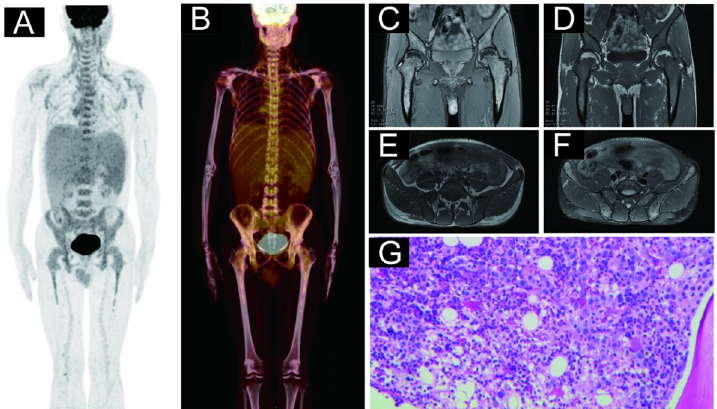
Fig 6. Representative case of a 45-year-old male diagnosed with diffuse large B-cell lymphoma. (A) and (B): Coronal positron emission tomography (PET) and PET-computed tomography images, respectively, revealing increased diffuse 18 F-fluorodeoxyglucose uptake (higher than that in the liver) in bone marrow throughout the patient’s body. (C)–(F): Pelvic magnetic resonance imaging revealing low signal intensity in the ilium, bilateral upper femur bones, and sacrum on the T1-weighted image, and high signal intensity in the same regions on the fat- suppressed T2-weighted image. (G): Hematoxylin and eosin staining confirmed bone marrow involvement in this patient. The patient’s blood glucose level before the PET/CT imaging was 5.0 mmol/L.